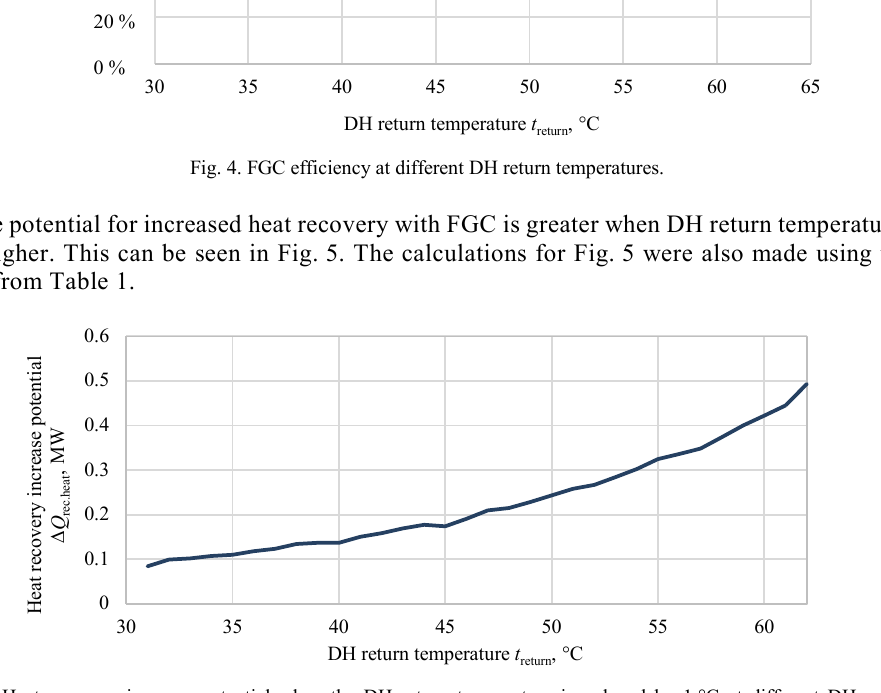
Fig. 5. Heat recovery increase potential when the DH return temperature is reduced by 1 °C at different DH return